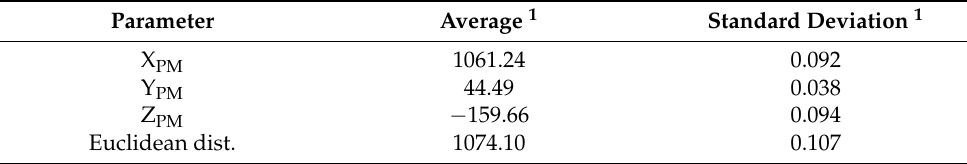
Table 3. Position-measurement uncertainty of the second object (N =